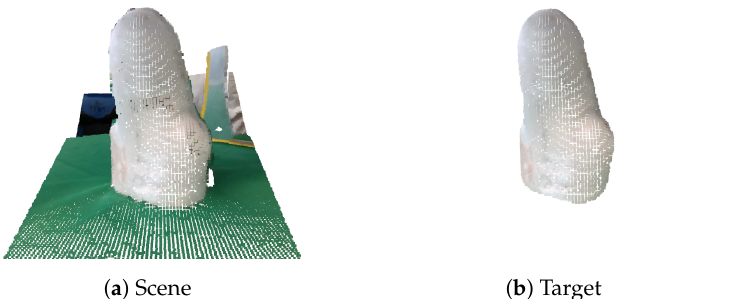
Figure 11. Comparison of the original scene ( a ) and the segmented target object ( b ). This demonstrates that the segmentation algorithms and PC conversion were working